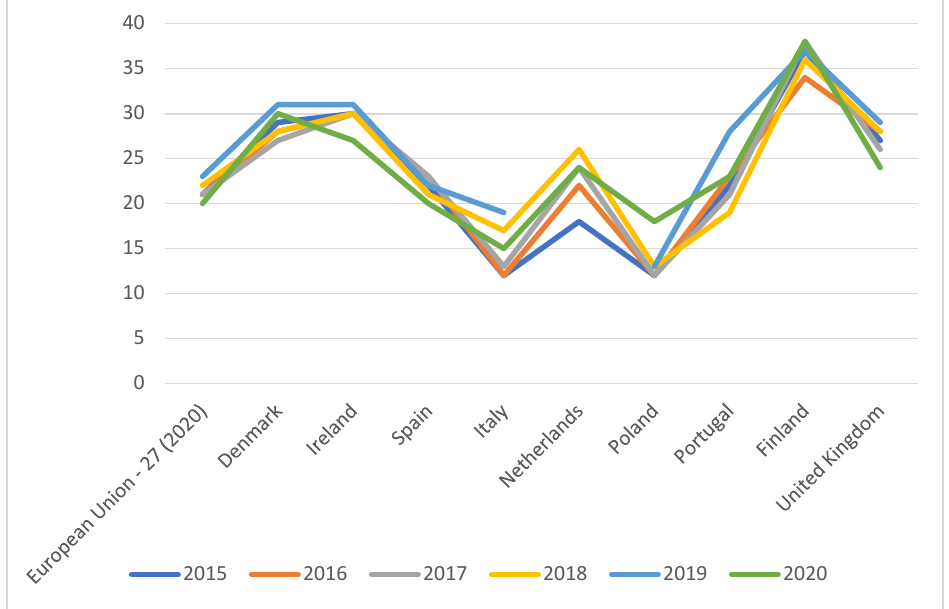
Figure 5. Training provided by enterprises in terms of technological skills (% of enterprises) with 10 or more workers. Note: value of Netherlands in 2019 was not supplied to the Eurostat database.